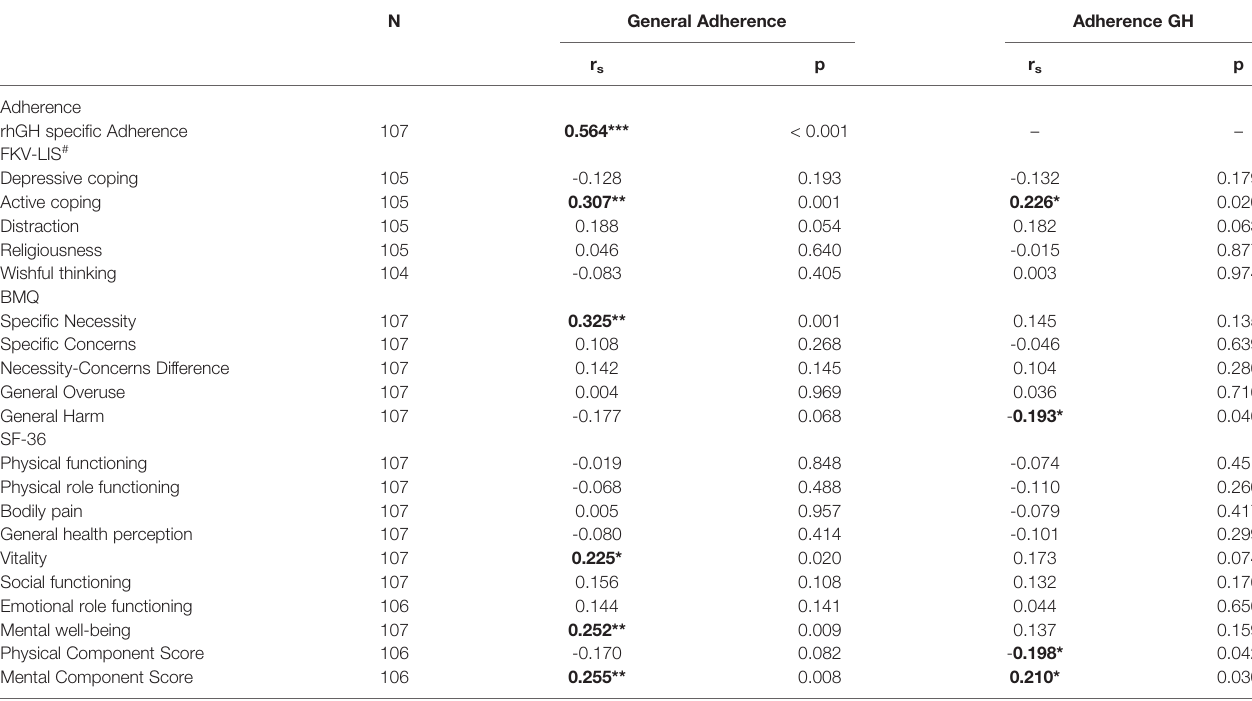
# Please note that abbreviated scale names for the FKV-LIS are reported here for better readability. For the full scale names please refer to the Methods section.*p< 0.05, **p< 0.01, ***p < 0.001.